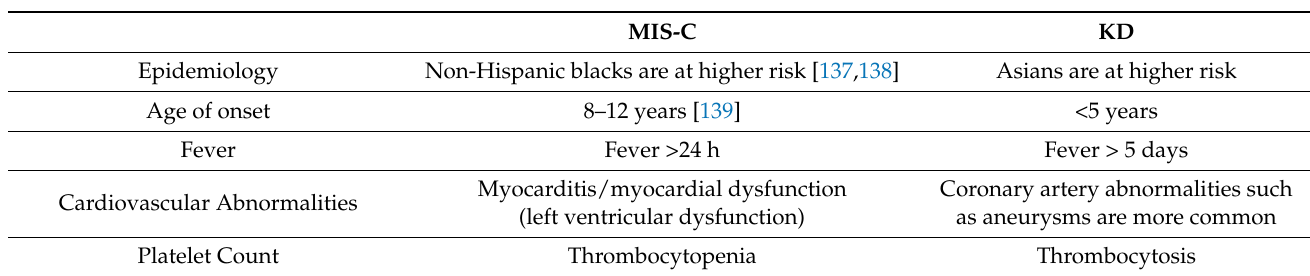
Table 2. Differentiation of Multisystem Inflammatory Syndrome in Children (MIS-C) and